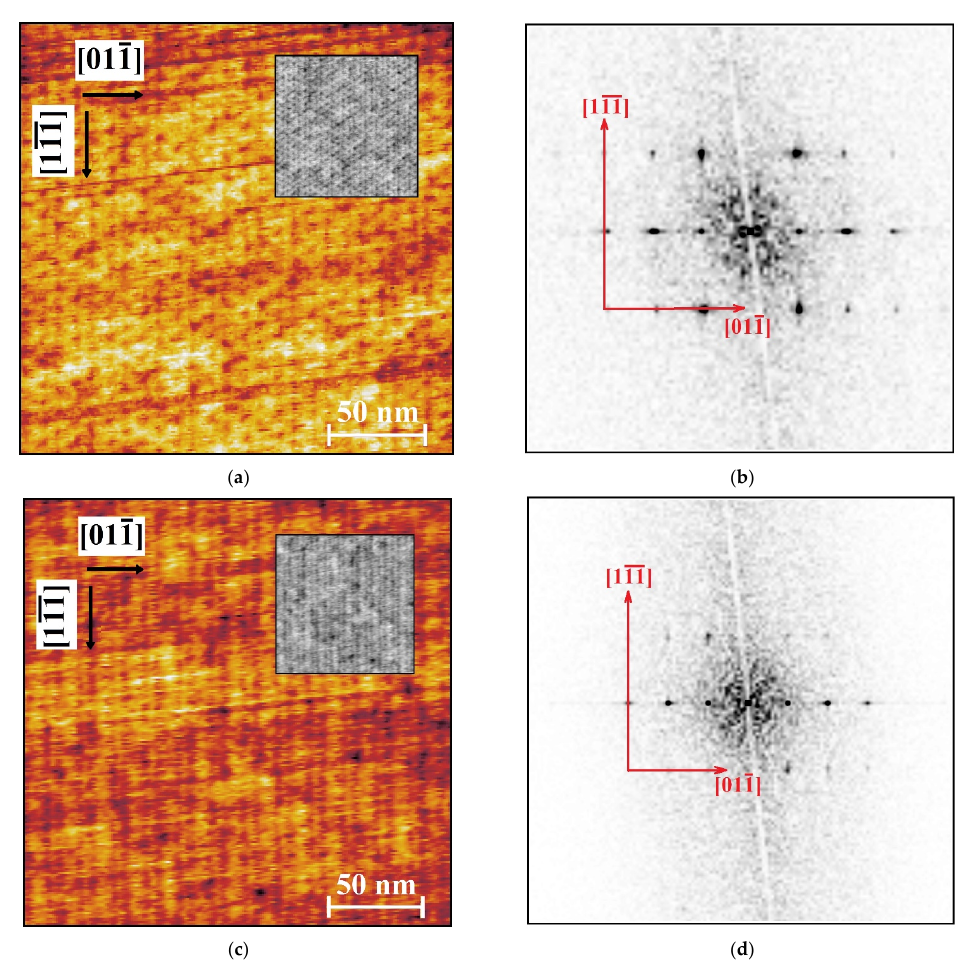
Figure 6. AFM images of the C8AzoPyr sample: ( a ) phase image and ( b ) FT pattern of the dry film (RH = 20%); ( c ) phase image and ( d ) FT pattern of the swollen film (RH = 100%). The insets show the corresponding AFM images after filtering in the Fourier space.